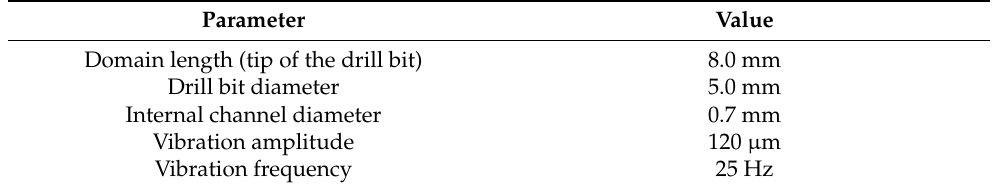
Table 1. Geometric dimensions of the numerical domain and operating conditions.